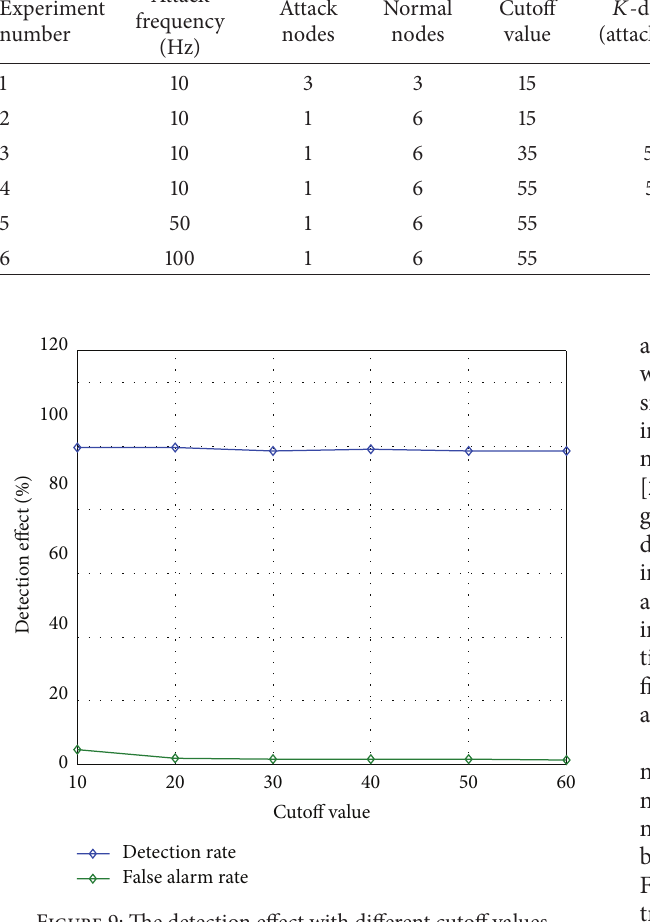
Figure 9: The detection effect with different cutoff